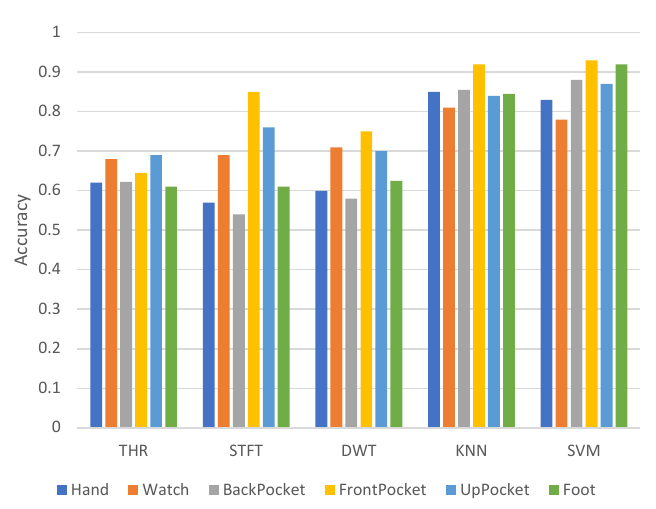
Figure 5. Context effects: window size.